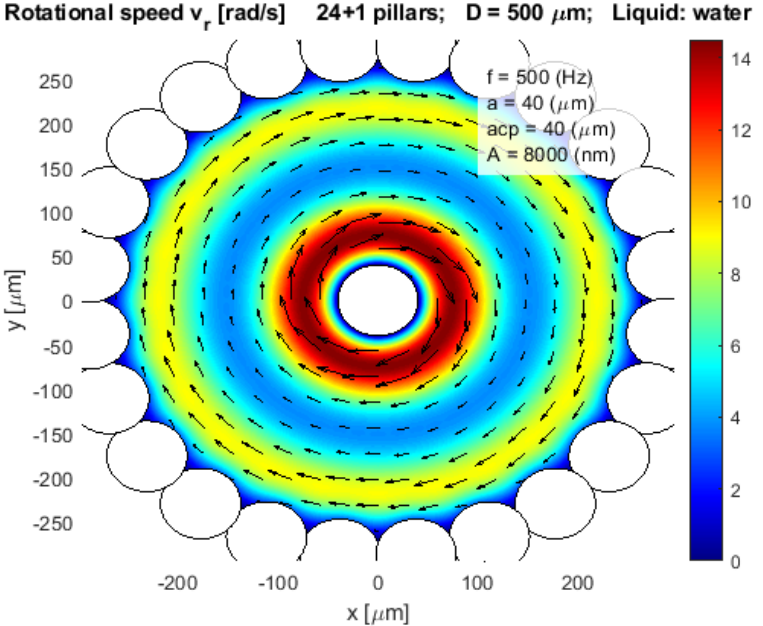
Figure 8. Rotational velocity of water stream 𝑣 𝑟 in a closed pot-like layout with a central pillar.